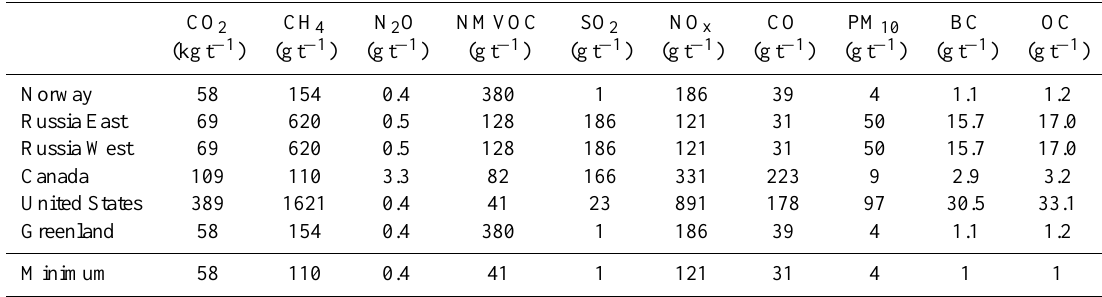
Table 1. The adopted emission factors per tonne oil equivalent extracted for 2004 (details in Supporting Information). SO 2 and NO x are based on the molecular weight and not the mass of S or N.